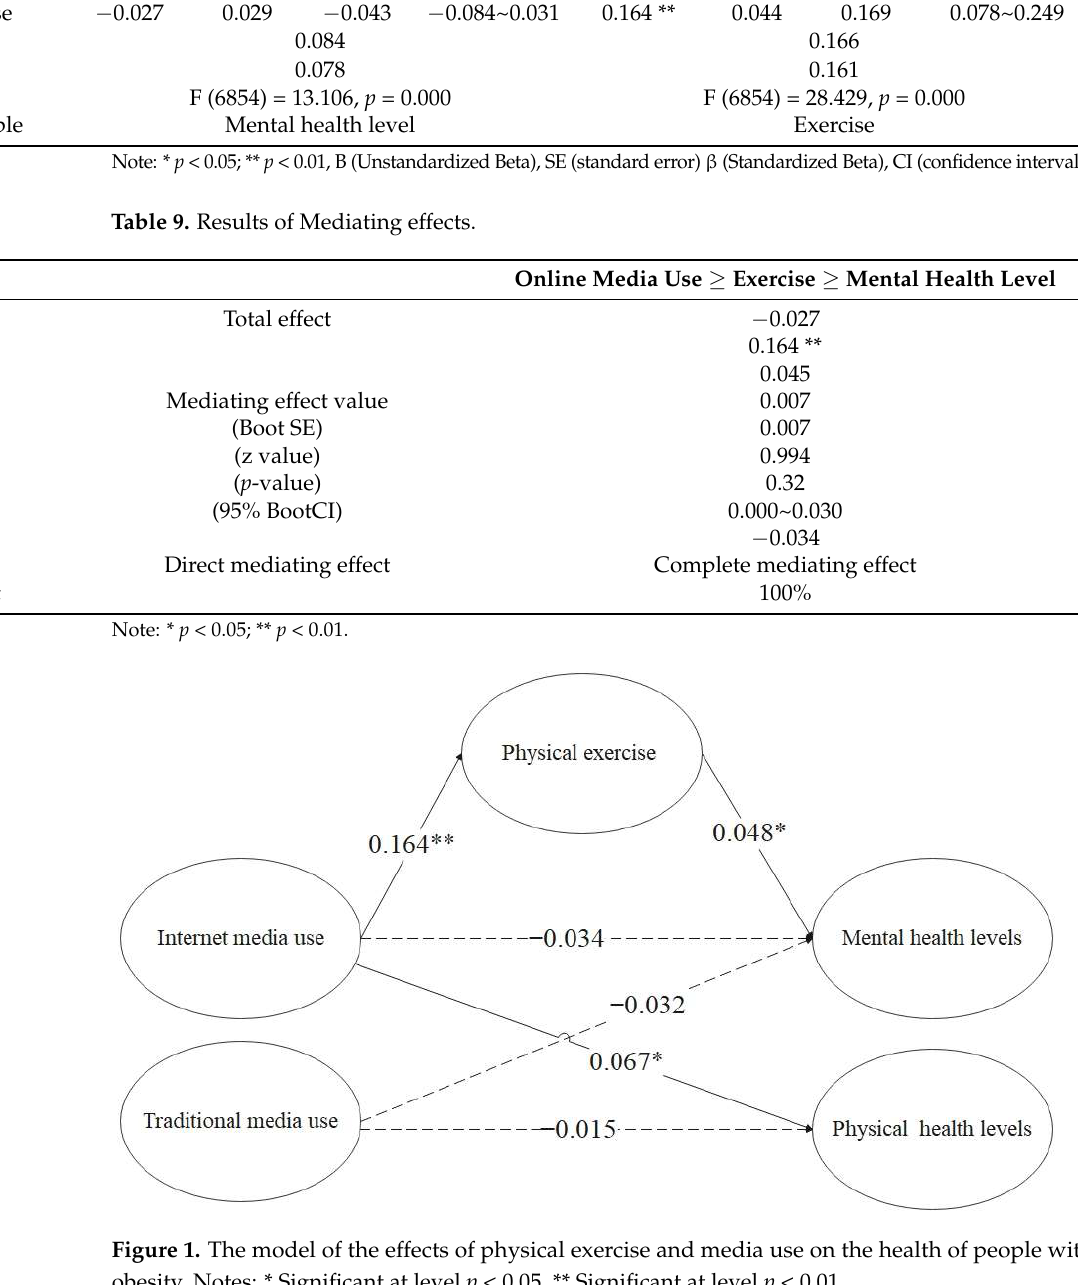
Figure 1. The model of the effects of physical exercise and media use on the health of people